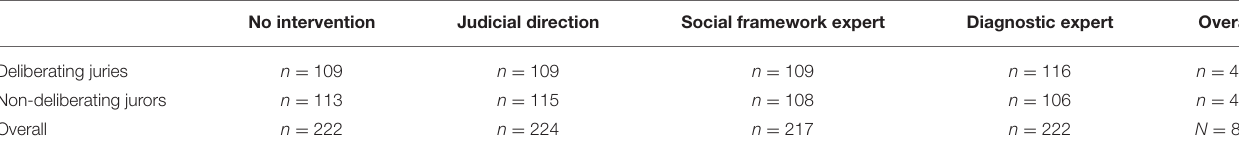
TABLE 1 | Illustration of experimental groups and number of participants in each condition. No intervention Judicial direction Social framework